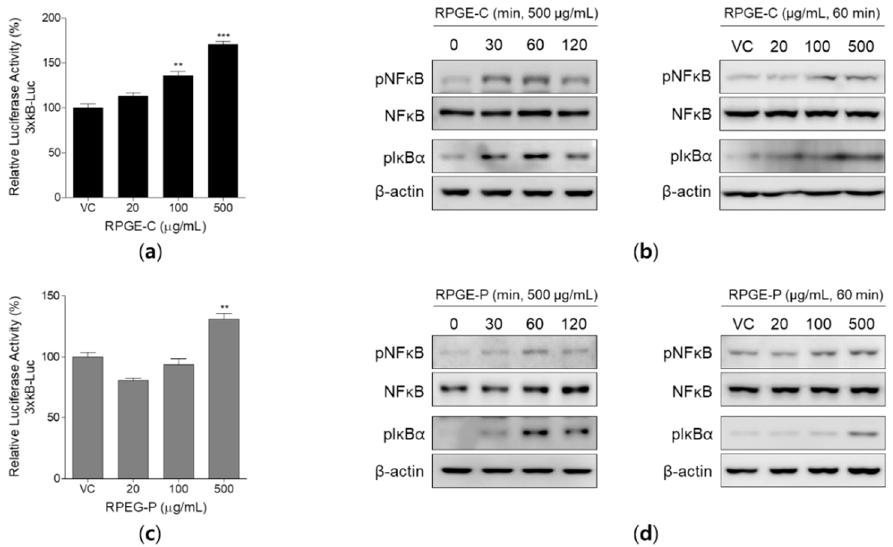
Figure 5. Effect of RPGE on NF- κ B activation in RAW 264.7 cells. ( a ) RPGE-C; ( c ) RPGE-P. Luciferase activity was expressed as a relative value to that of the VC, which is set to 100%. The figures show the mean ± SEM. *p < 0.05 and ***p < 0.001. ( b ) The cells were treated with 500 μ g/mL of RPGE-C for the indicated times or indicated concentrations for 60 min prior to Western blot analysis; ( d ) The cells were treated with 500 μ g/mL of RPGE-P for the indicated times or indicated concentrations prior to Western blot analysis.